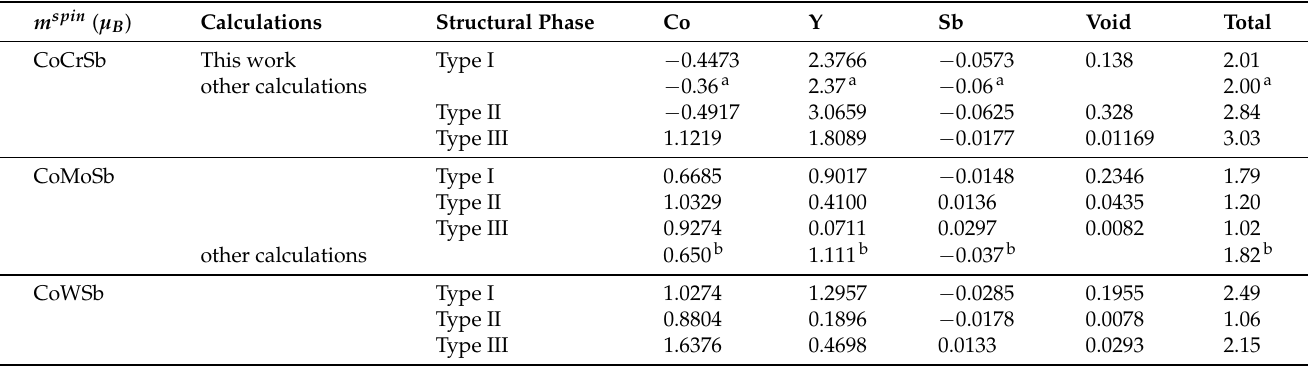
Table 3. The calculated spin magnetic moments in µ B for CoYSb (Y = Cr, Mo, W) compounds for the three possible structural phases comparing with available